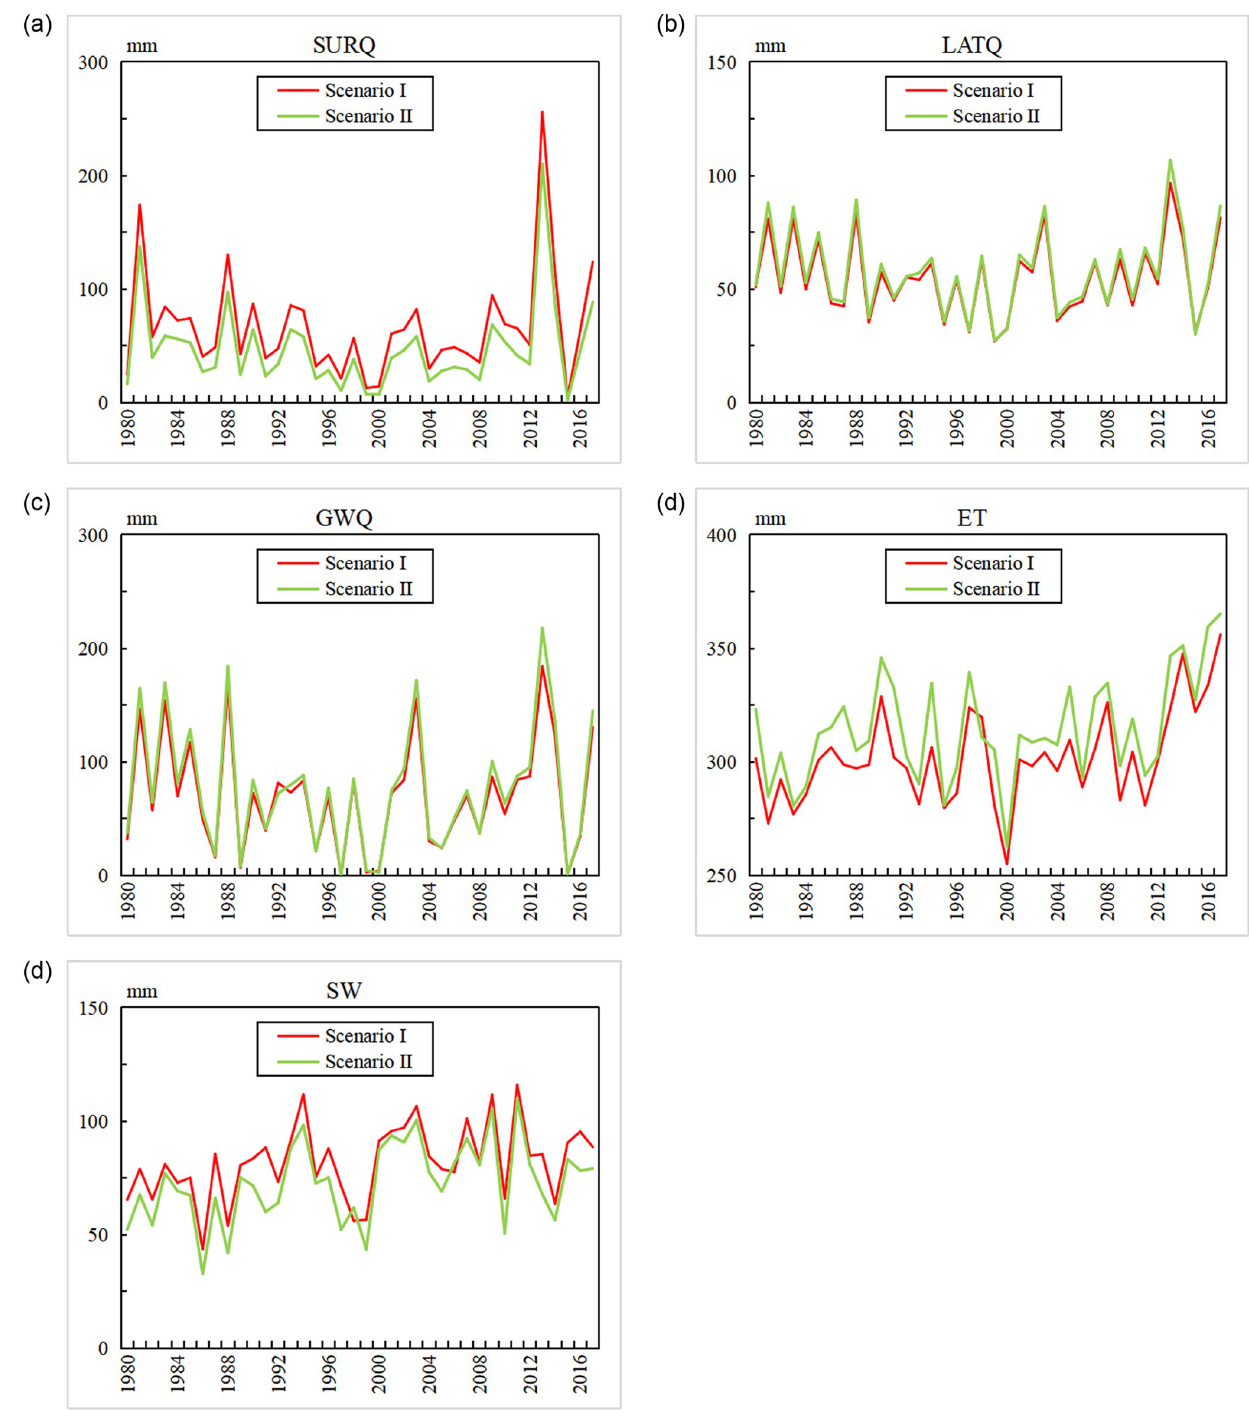
Fig 6. Temporal changes of the hydrological elements.